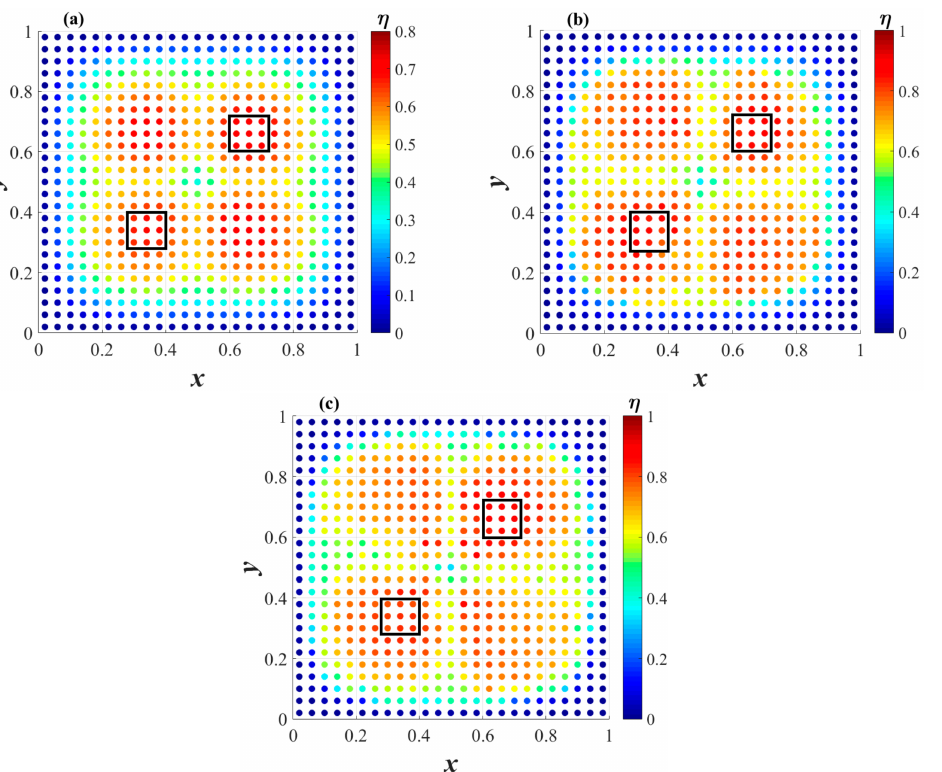
Figure 11. The energy dissipation ratios of single NES at different positions under different excitation amplitudes: ( a ) f = 1; ( b ) f = 3; and ( c ) f = 5.